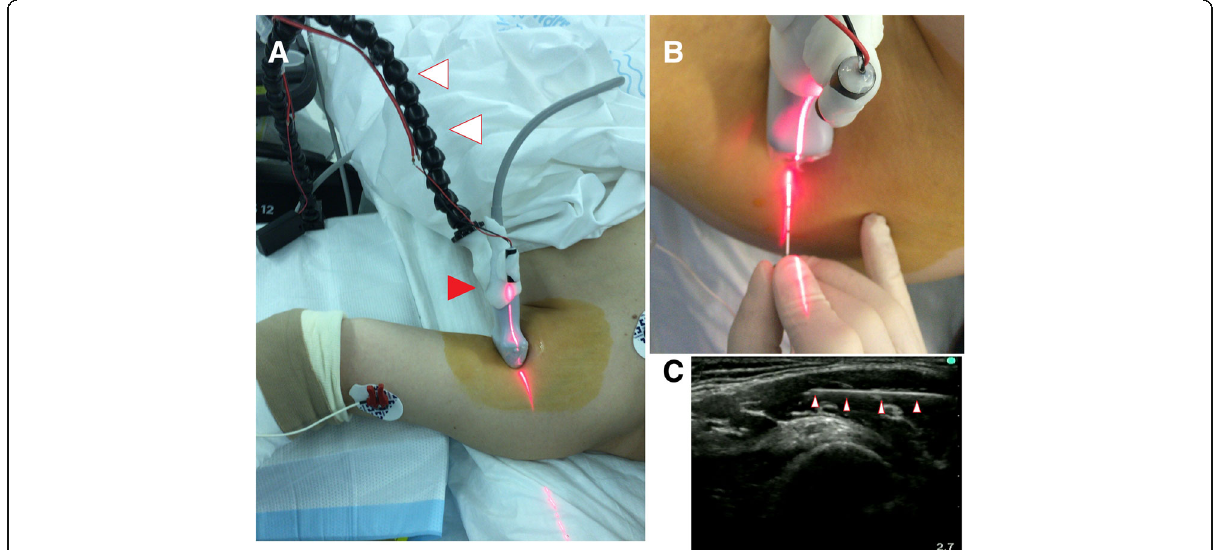
Fig. 1 a This holder is composed of a flexible arm (white arrows), a holding part, and a laser device (red arrow). b With the use of the probe holder, the probe could be held more stable than with the free-hand procedure. The laser navigation assures reliable administration of ultrasound-guided nerve block. c The ultrasound image (needle, white